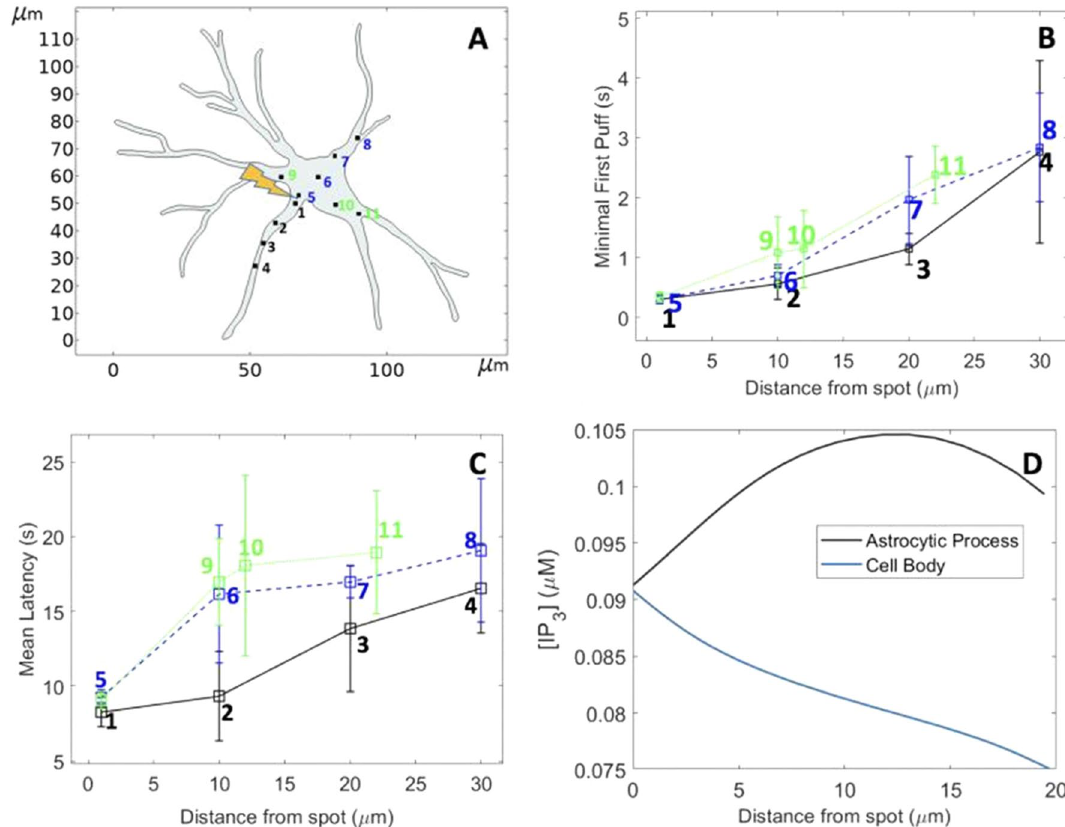
Figure 7. Computational simulations of IP 3 diffusion and Ca 2+ puff occurrence in response to the localized photorelease of a non-metabolizable IP 3 analogue in a 2D geometry resembling an astrocyte, assuming an effective diffusion coefficient of IP 3 ( D I ) of 100 μm 2 s −1 . ( A) Shape of the astrocyte redrawn in COMSOL Multiphysics from images of Gonçalves-Pimentel et al. 38 . Locations of the clusters considered in the simulations are indicated and labelled in black in the astrocytic process and in blue and green in the cell body. IP 3 photorelease was assumed to occur between locations 1 and 5. Simulation procedures are the same as for Fig. 4 (main text), with θ = 250 μms −1 and flash duration = 500 ms. Panels ( B and C) show the minimal first puffs and the mean first puff latencies at the different locations, respectively. At equal distance from the IP 3 release point, puffs occur sooner in the process than in the body. Panel (D) shows the distribution of IP 3 2 s after the flash: higher local IP 3 concentrations are reached in the process in which there is no dilution effect. The spatio- temporal evolution of